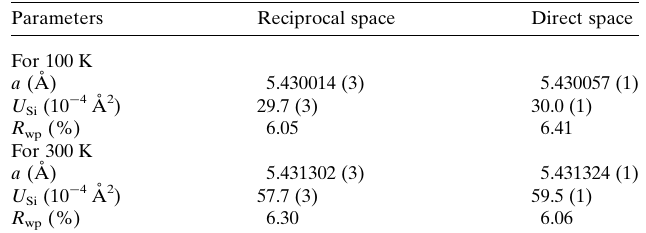
Table 2 Structural parameters from the reciprocal- and direct-space refinements of Si at 100 and 300 K.